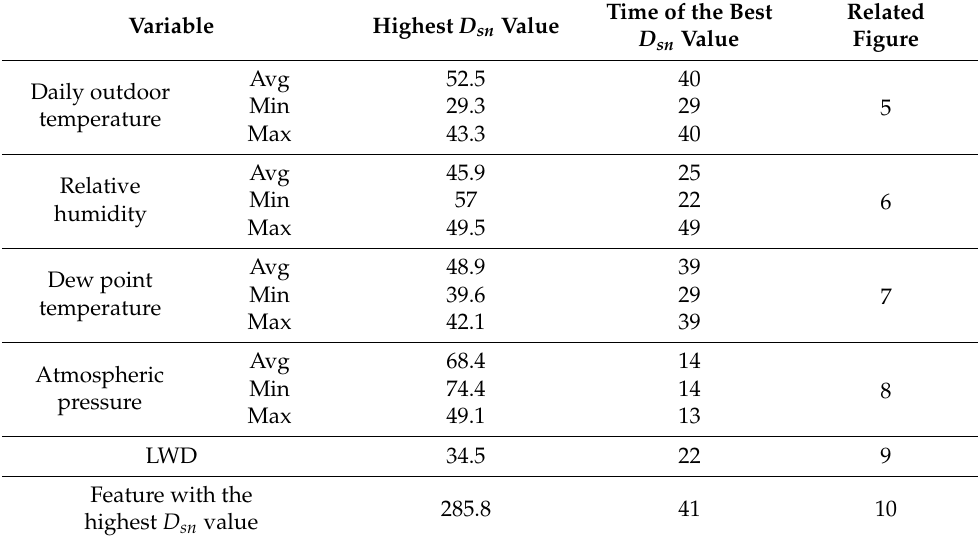
Table 2. Highest D sn values of analysed variables, related to Figures 5–10.